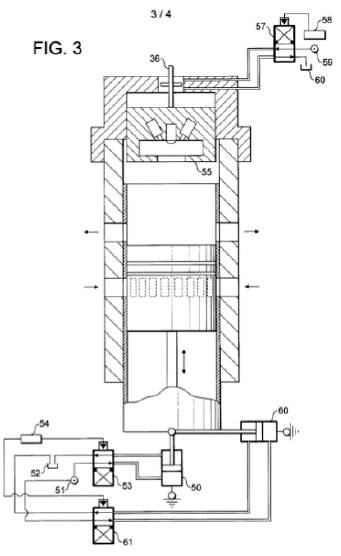
Figure 24. J. Turner Lotus 18 November 2005, sleeve valve engine 2005 GB 2432398A. Reproduced